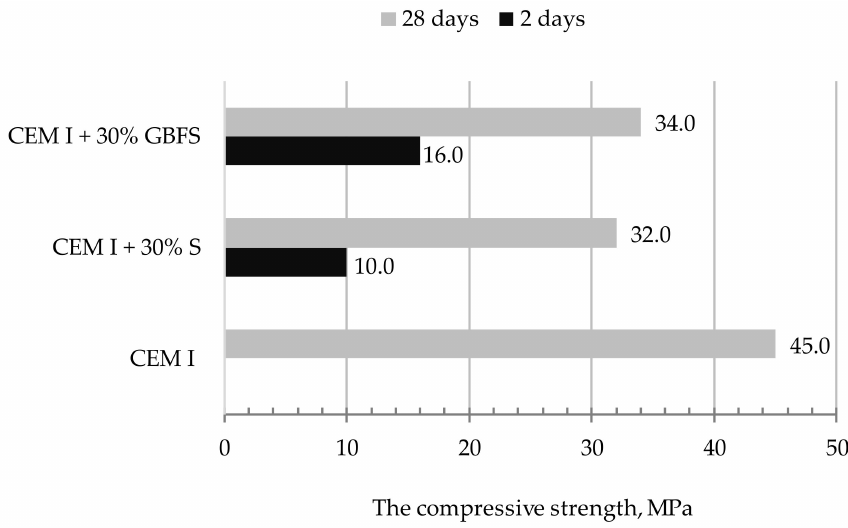
Figure 11. Results of compressive strength of mortars after 2 and 28 days of